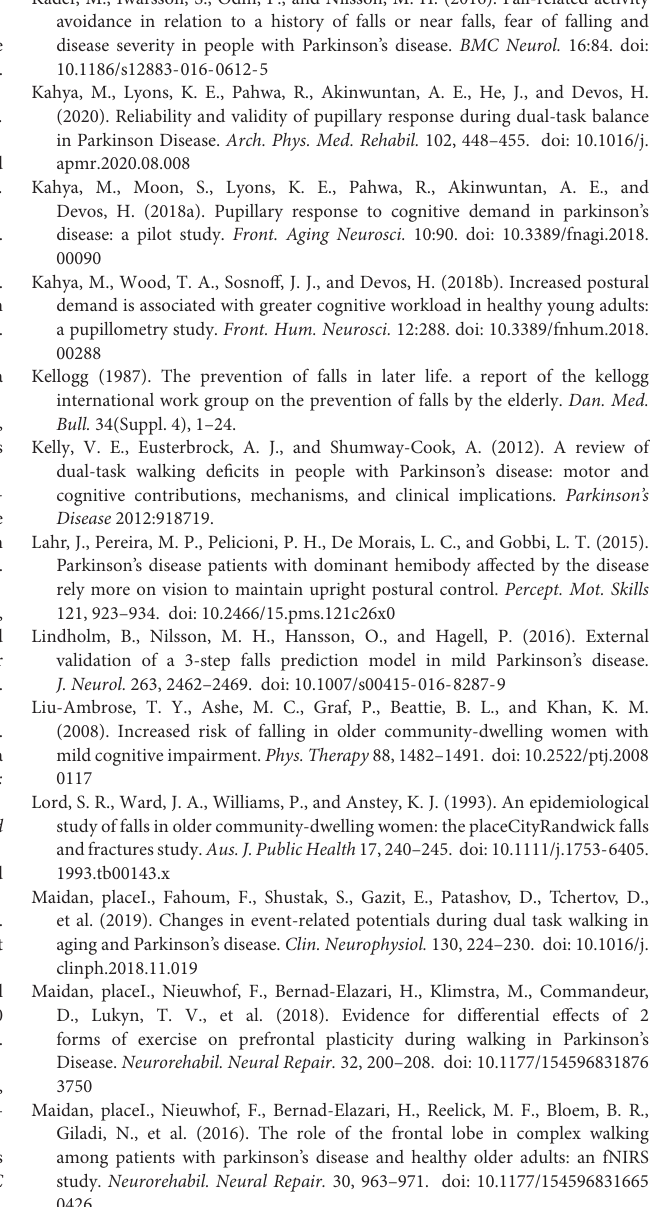
II = Movement Disorder Society Unified Parkinson Disease Rating Scalemotor experiences of daily living; MDS-UPDRS III = Movement Disorder Society Unified Parkinson Disease Rating Scalemotor examination; H&Y = Hoehn and Yahr; LED = Levodopa Equivalent Dose; SCOPA-AUT = Scales for Outcomes in Parkinson’s Disease-Autonomic questionnaire; N/A = Not Applicable. FES-I = Falls Efficacy Scale-International, TUG = Timed Up and Go; TUG-COG = Timed Up and Go-Cognitive. The results are presented as mean ± standard deviation except for the sex